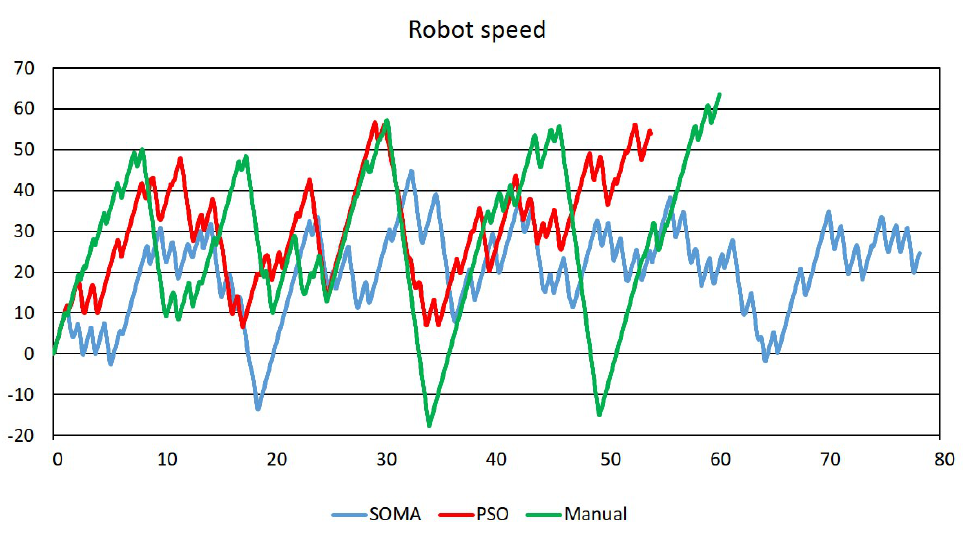
Figure 13. Comparison of robot speeds for FCMs designed with help of PSO, SOMA, and manual set-up.